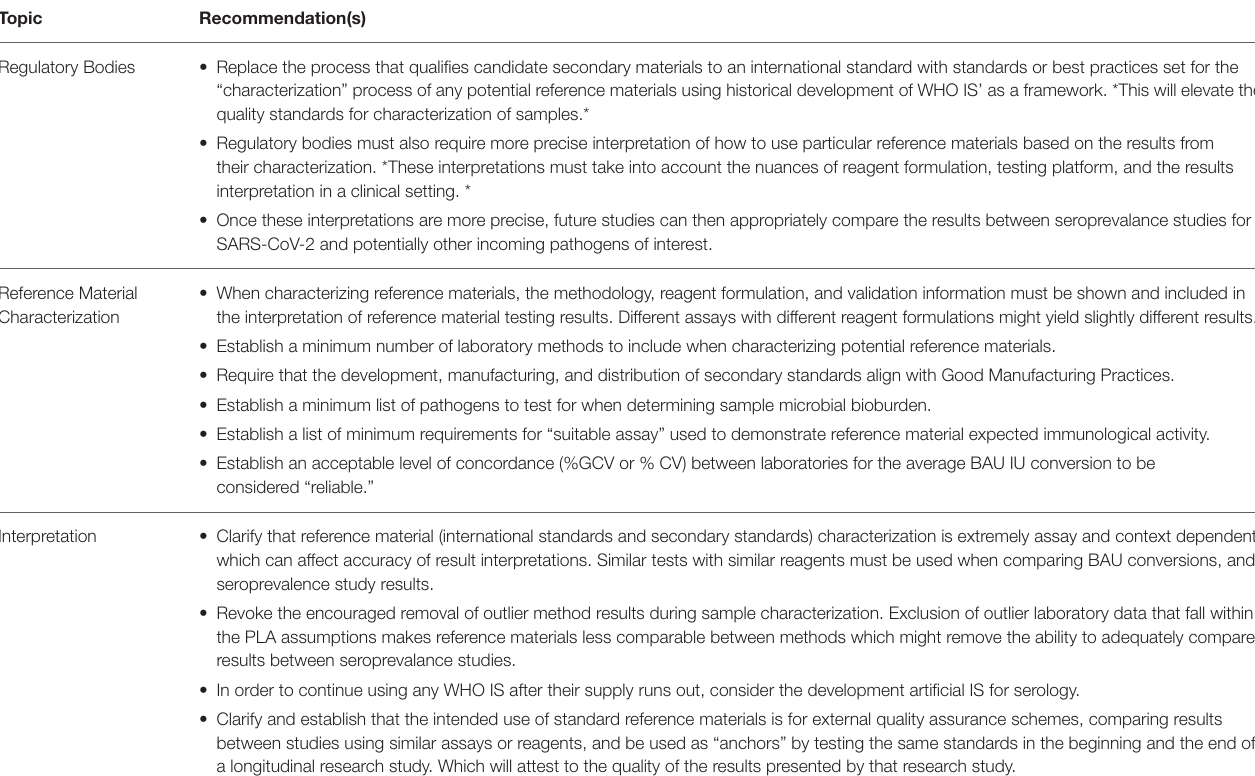
TABLE 4 | Recommendations for future development, use, and interpretation of International and Secondary Standards.